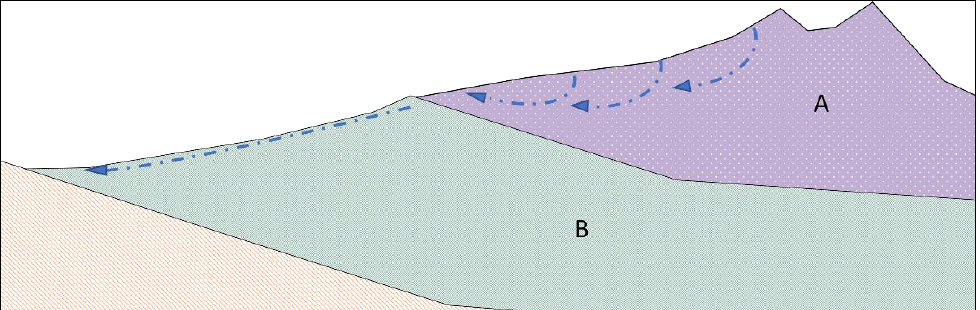
Figure 2. Generalized geological cross section of the study area where ( A ) represents the High Cascade Province, which is more permeable, allowing for rapid groundwater exchange, while the Western Cascade Province ( B ) encourages surface runoff due to less permeable characteristics.